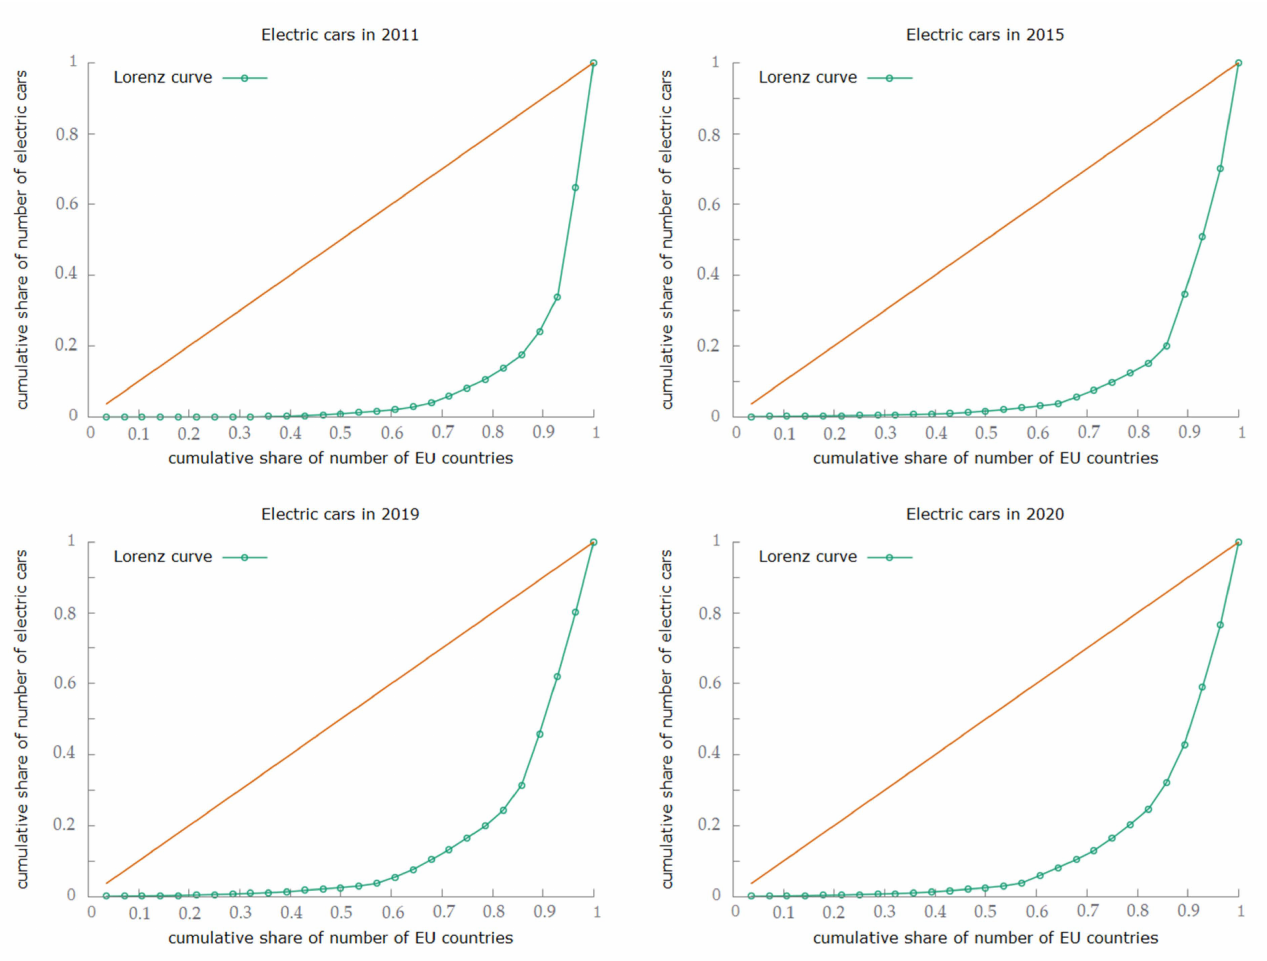
Figure 4. Lorenz concentration curves for number of electric cars in the EU countries in